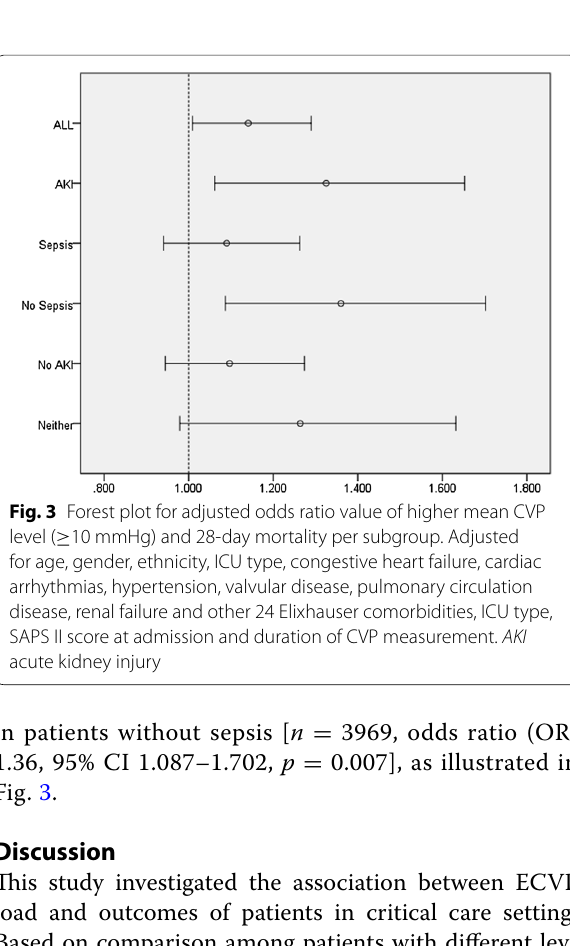
load during the first 10